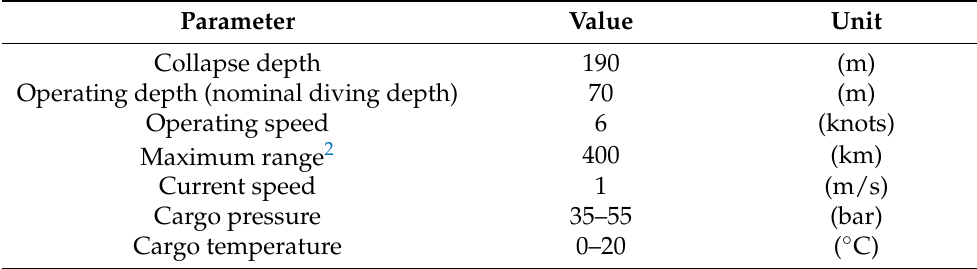
Table 1. Baseline subsea shuttle tanker (SST) operating